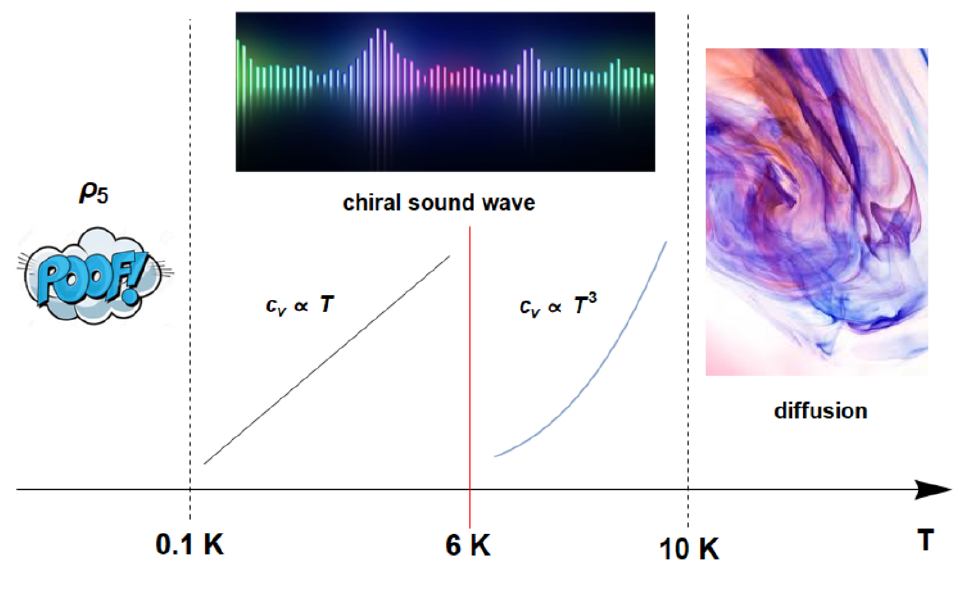
Figure 1: Fate of the chiral sound and behavior of the specific heat discussed in the text. For T < 0.1 K the internode life time is too short and the chiral sound wave would not propagate. A linear behavior of the specific heat will prevail in the range 0.1 K < T < 6 K and the T 3 phonon contribution takes over at T > 6 K . For T > 10 K the chiral wave will be